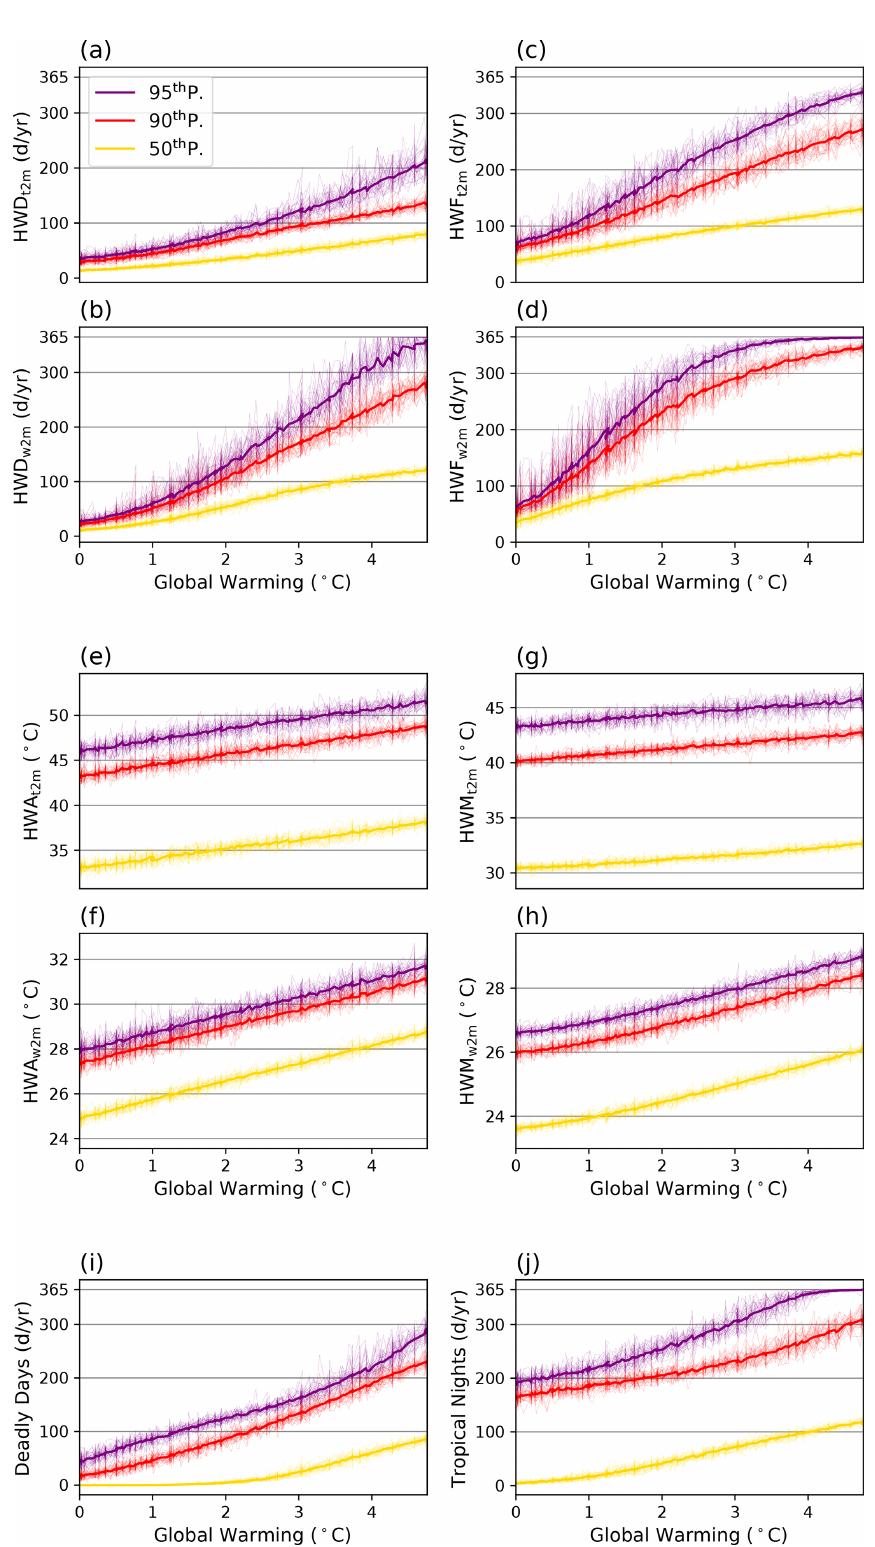
Figure 7. Changes in population-weighted heat wave indices as a function of global average warming. Each line denotes one ensemble member for different percentiles of the